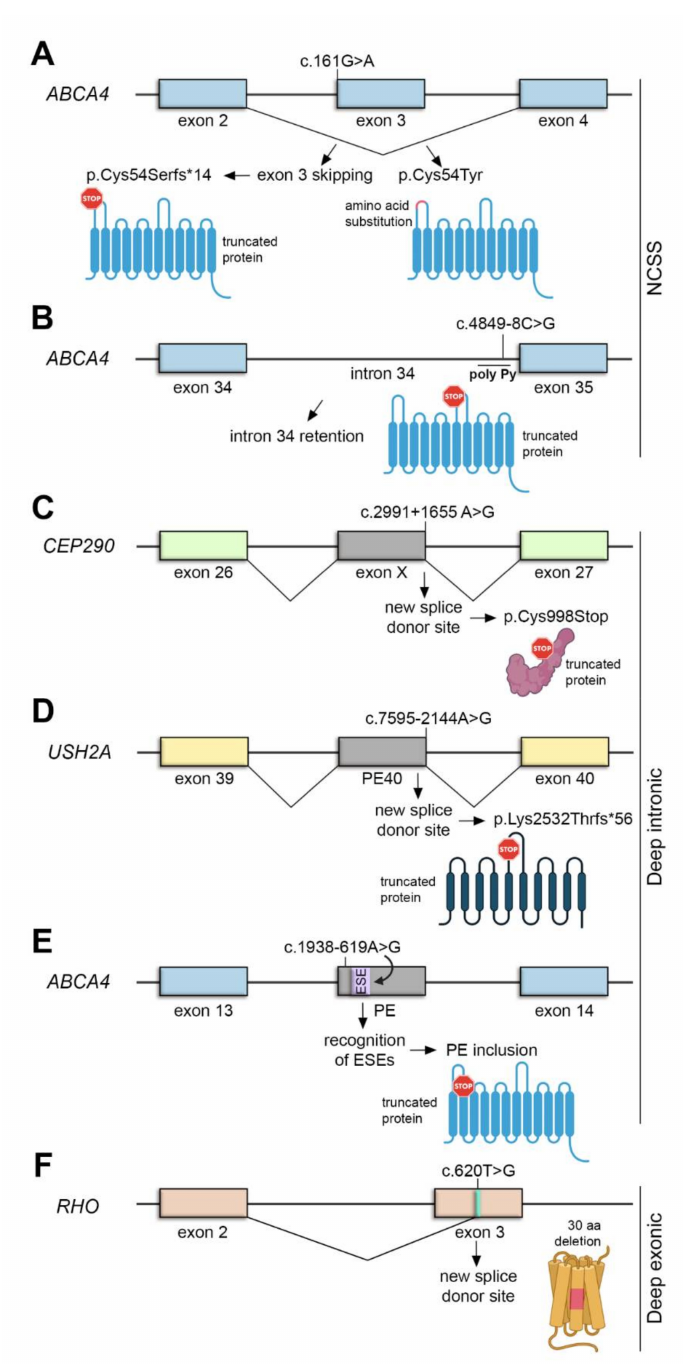
Figure 4. Overview of cis acting mutations altering splicing: NCSS ( A , B ), deep intronic ( C – E ) and deep exonic variants ( F ). ( A ) ABCA4 exon 3 shows a weak natural exon skipping. The c.161G>A mutation increase exon 3 skipping (producing a truncated ABCA4 protein) and the p.Cys54Tyr amino acid substitution. ( B ) The ABCA4 c.4849-8C>G mutation lowers the value of the poly-Py tract, thus causing intron 34 retention and production of a truncated protein. ( C ) The CEP290 c.2991+1655A>G mutation creates a new SDS, that induce inclusion of a cryptic exon (exon X) encoding a premature stop codon. ( D ) The USH2A c.7595-2144A>G mutation creates a new SDS that causes pseudoexon inclusion (PE40) and introduces a premature stop codon. ( E ) The ABCA4 c.1938-619A>G mutation, located in a cryptic pseudoexon (PE), leads to the recognition of ESEs that promote PE inclusion, leading to the truncation of the protein. ( F ) The RHO c.620T>G mutation creates a strong splice donor site that results in a 30 amino acid in-frame